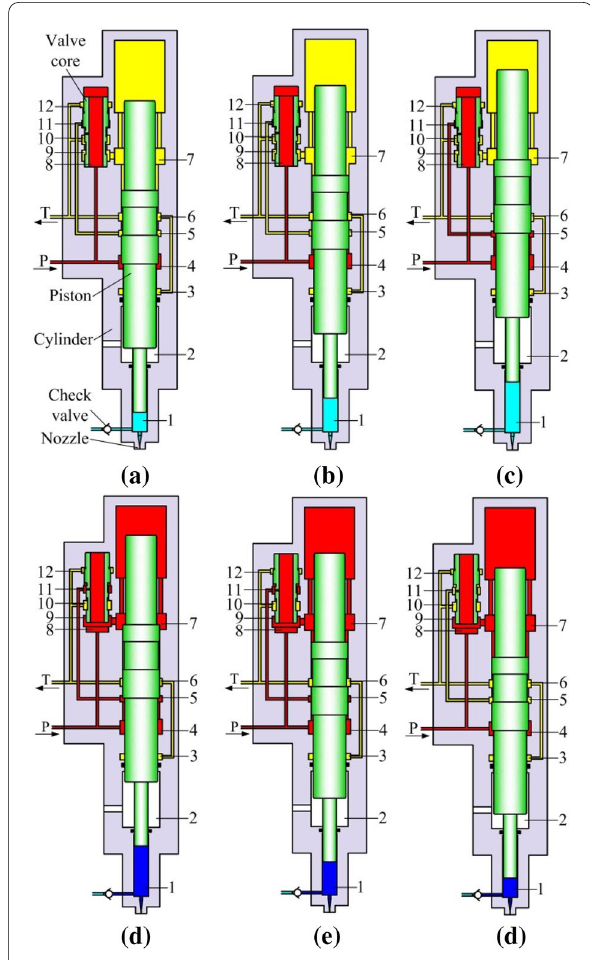
Figure 6 Working process of the